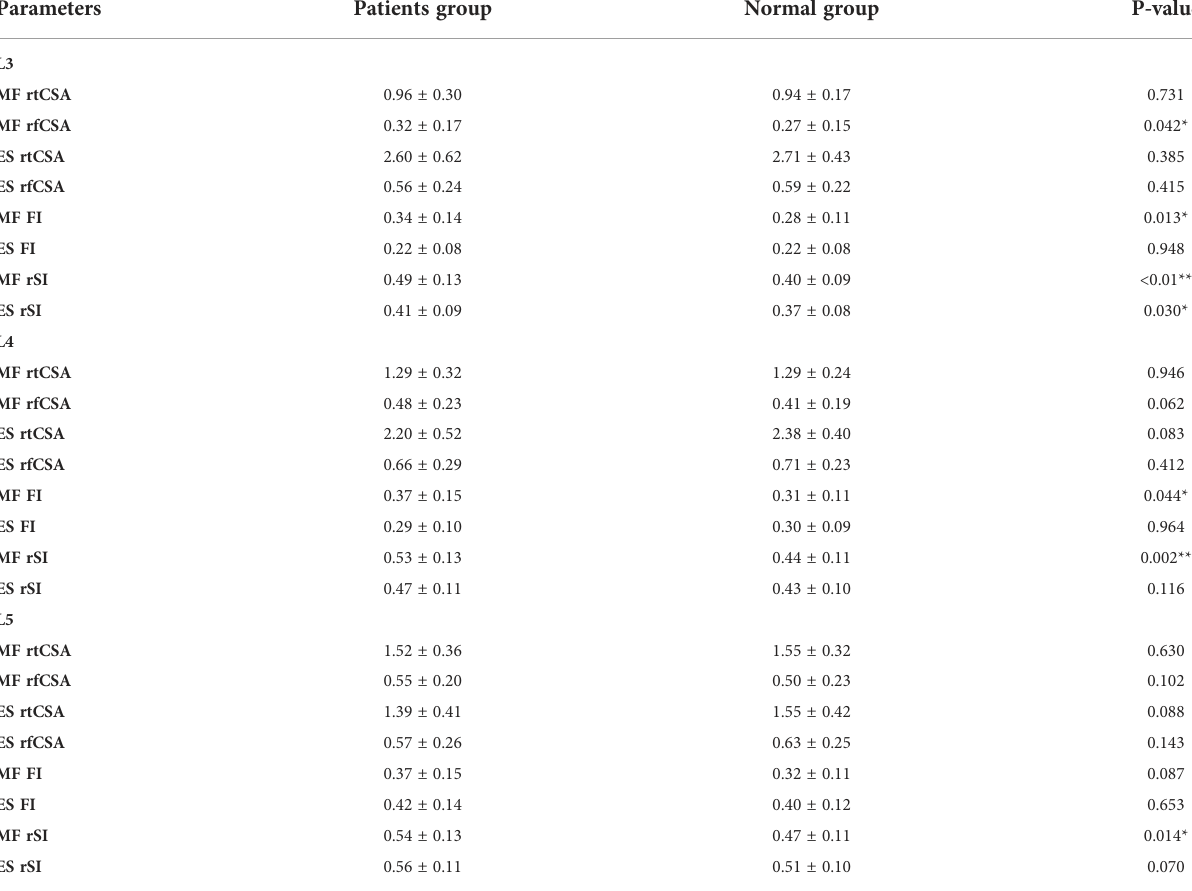
TABLE 2 The comparison of paraspinal muscle parameters at L3 to L5 levels. Parameters Patients